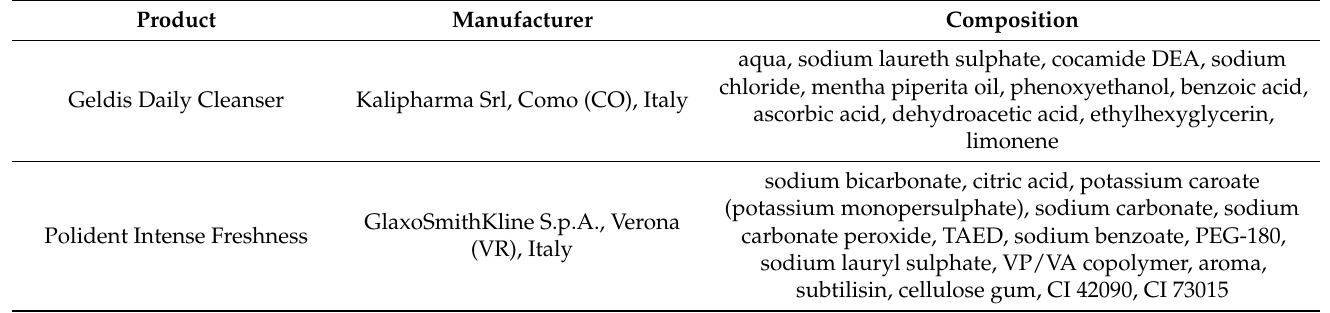
Table 1. Composition of the tested